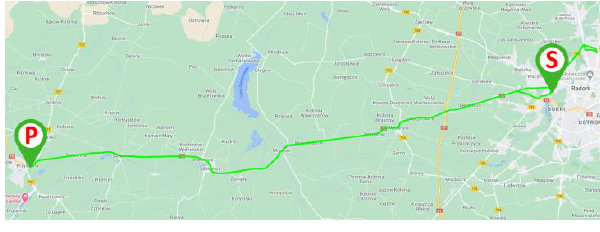
Fig. 10. The map with a marked daily route